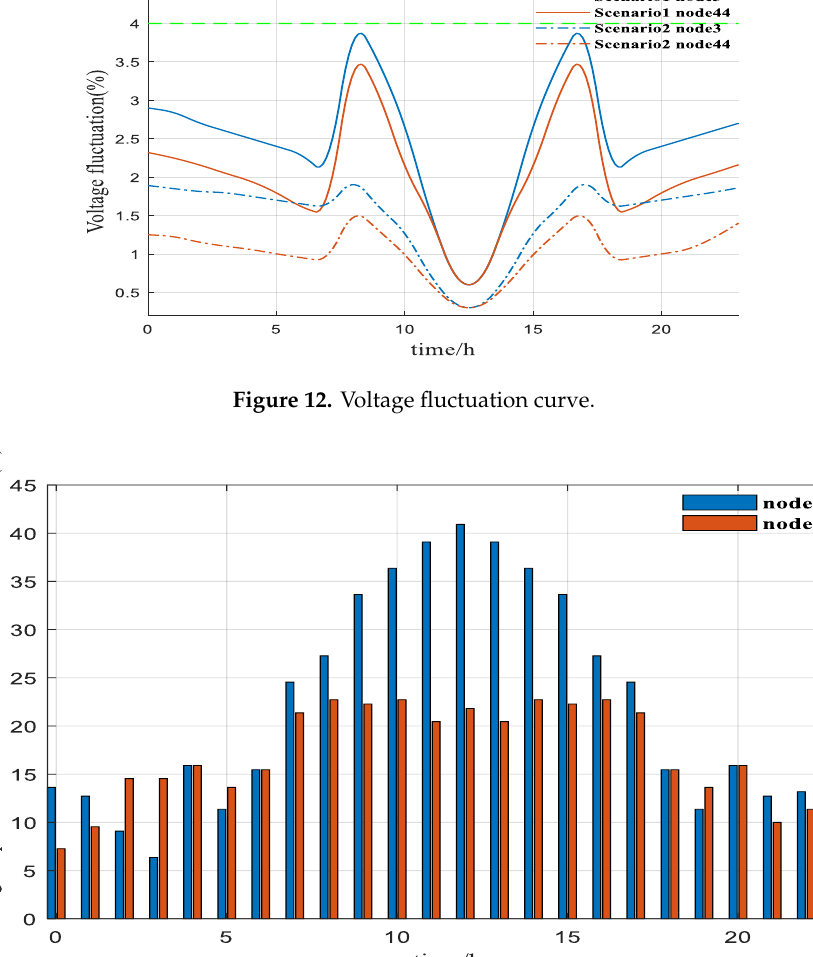
Figure 13. Percentage improvement of current harmonic distortion rate relative to the standard value.